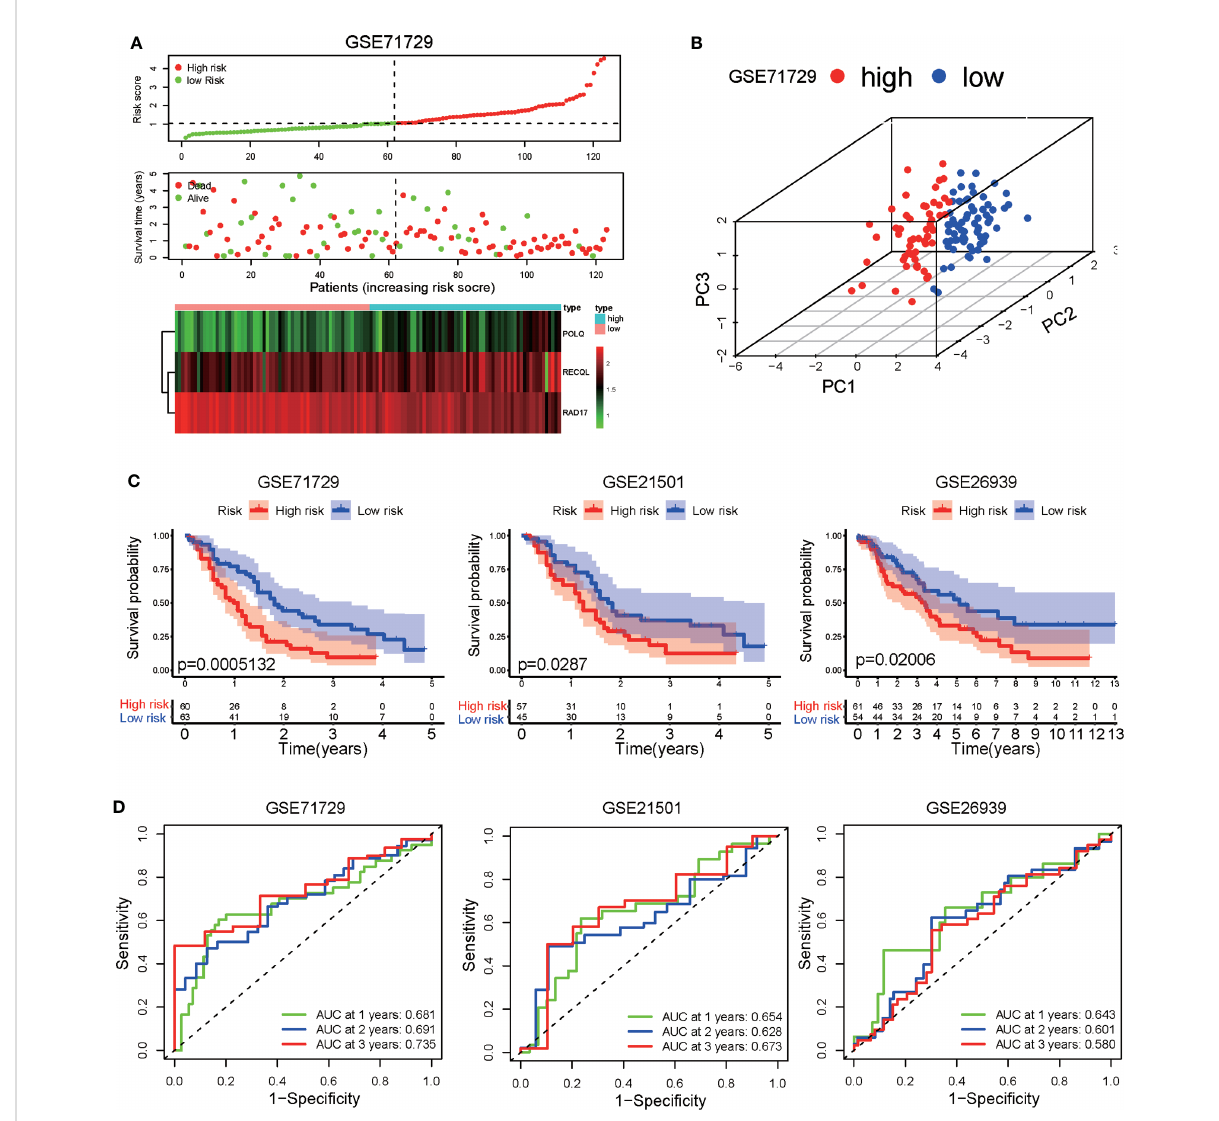
FIGURE 2 Validation of the DRG signature in three independent GEO datasets (GSE71729, GSE21501, and GSE26939). (A) Distribution of risk scores, survival status, and expression level of three DRGs in the GSE71729 dataset. (B) Principal component analysis based on the expression levels of three DRGs in the GSE71729 dataset. (C) Kaplan − Meier analysis of OS in the high-risk and low-risk groups in three GEO datasets. (D) Time- dependent ROCs for 1-year, 2-year, and 3-year OS predictions based on the DRG signature in three GEO